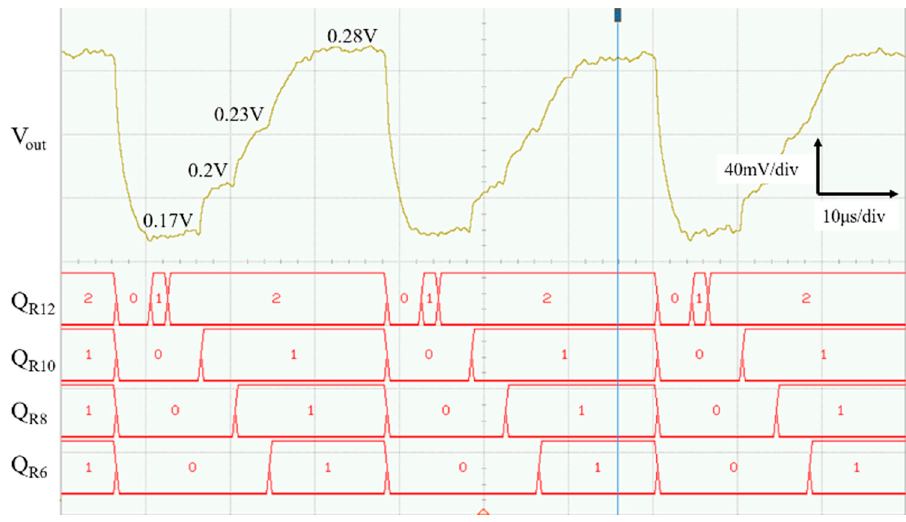
Figure 9. MPPT measurement with P in is − 21 dBm and output loading of 600 k Ω .